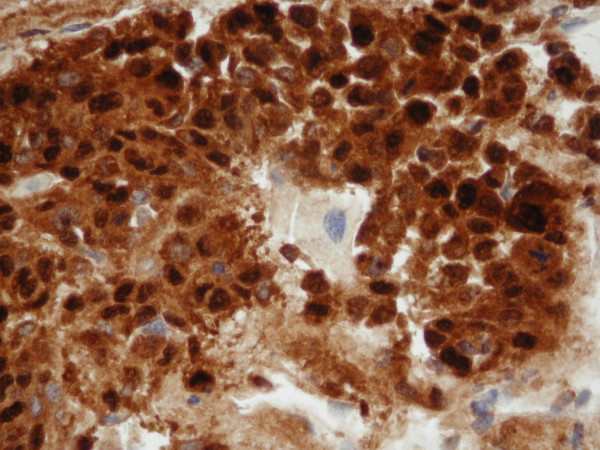
Immunohistochemistry of the liver. S-100 antibody stains malignant melanocytes with a brown chromogen (diaminobenzidine). Rare negative cells (blue due to hematoxylin counterstaining) are intact hepatocytes.